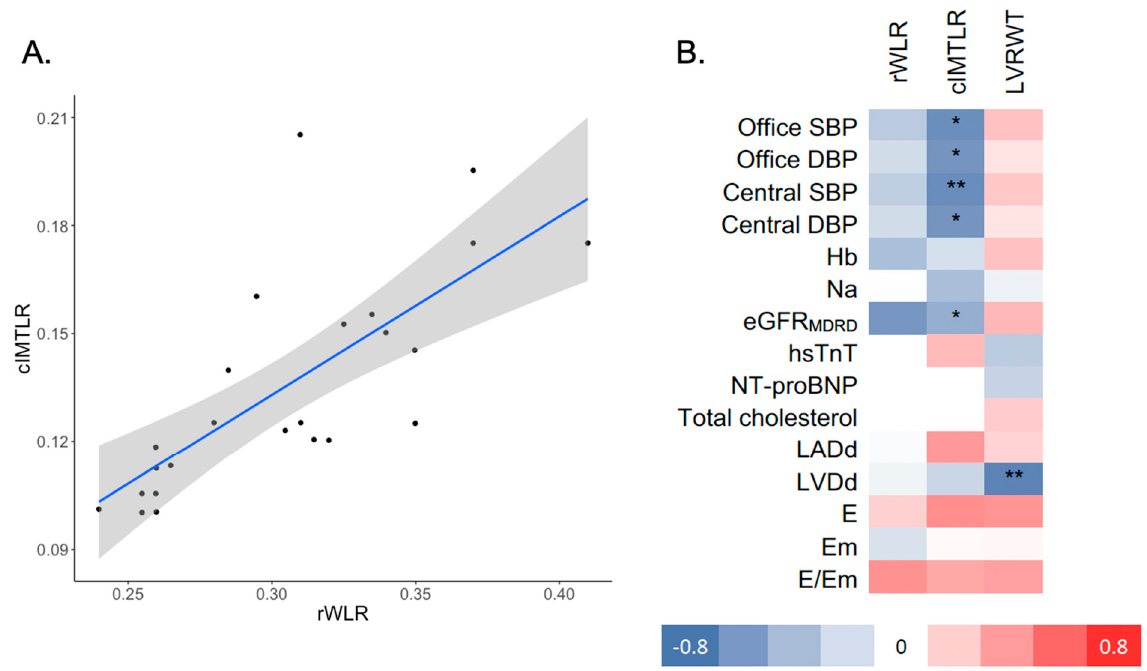
Figure 1. ( A ) Scatterplot presenting correlation between rWLR and cIMTLR and ( B ) heatmap of Spearman correlation coefficients between rWLR, cIMTLR, LVRWT and selected clinical covariates. * p < 0.05, ** p < 0.01; rWLR—retinal wall-to-lumen ratio; cIMTLR- carotid intima to media ratio; LVRWT—left ventricle relative wall thickness; Hb—hemoglobin; eGFR MDRD —estimated glomerular filtration rate; hsTnT—high-sensitivity troponin T; NT-proBNP—N-terminal prohormone of brain natriuretic peptide; LADd—left atrium diameter (diastolic); LVDd—left ventricle diameter (diastolic); LVRWT—left ventricle relative wall thickness; LVMI—left ventricle mass index; LVEF—LV ejection fraction; E—early diastolic mitral inflow velocity; Em—early diastolic mitral annular velocity . Table 3. Differences in retinal, carotid and echocardiographic markers between HFpEF and control groups.